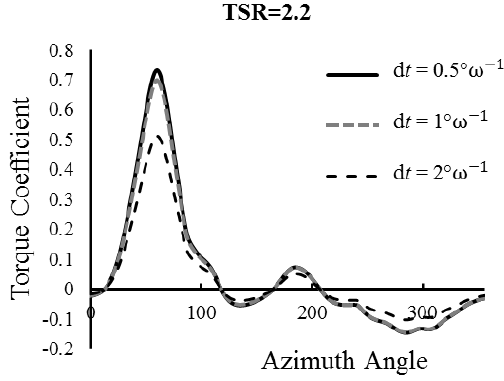
Figure 7. Time dependency study.